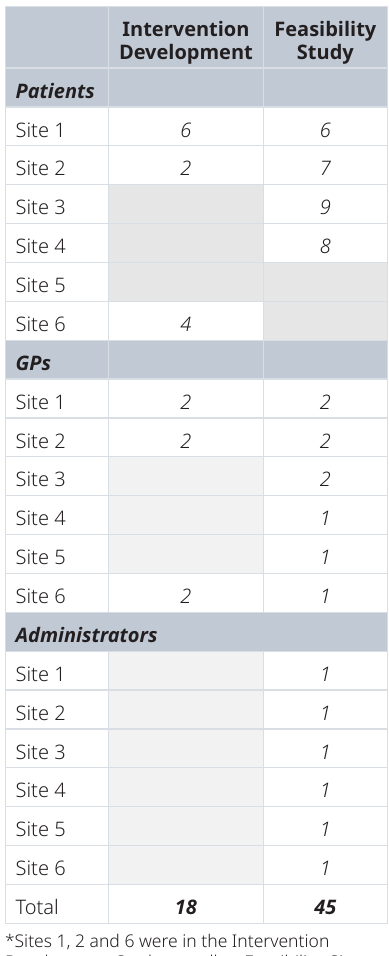
Table 6. Patient and practice interviewees for the pre-consultation